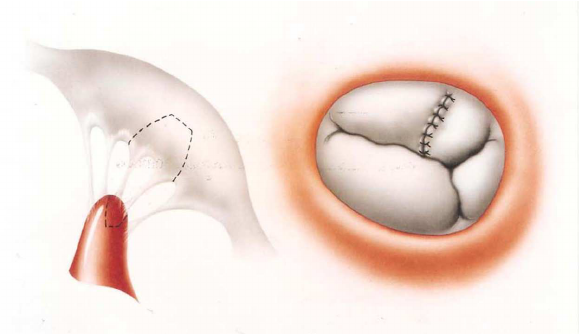
Fig. 6 – Left: a triangular patch is removed from the anterior leaflet of the tricuspid valve, with a satisfactory number and texture of chordae and a wedge of the papillary muscle which is transferred to the mitral valve. Right: sectioned edges of the anterior leaflet is joined with separated 5-0 polypropylene